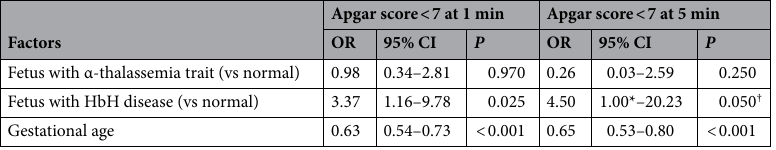
Table 5. Binary logistic regression with backward elimination (Backward Likelihood Ratio), of factors associated with low Apgar score among thalassemic women. *Lower limit of 95% confidence interval for odds ratio = 1.000024. † P =